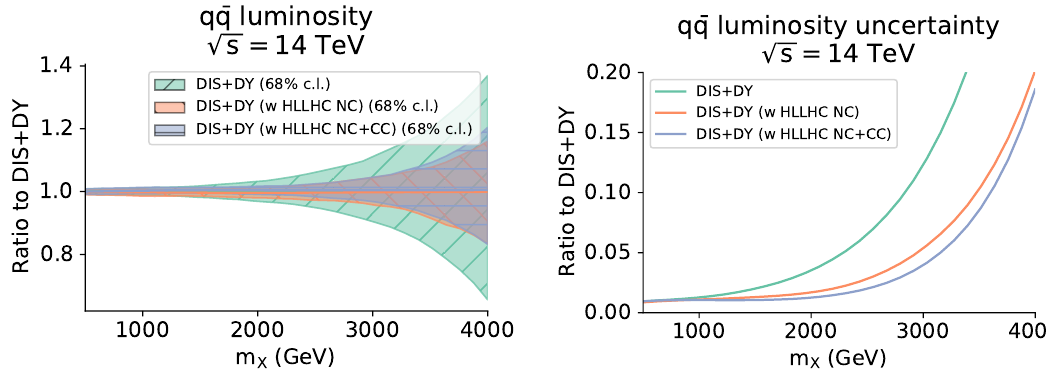
Figure 14 . Impact of the HL-LHC pseudo-data on the quark-antiquark luminosity L q ¯ q of the SM PDF baseline fit as a function of m X . Left: the luminosities L q ¯ q for the DIS+DY baseline and the corresponding fits including the HL-LHC pseudo-data, either only NC or also with CC cross sections, presented as a ratio to the central value of the former. Right: the relative PDF uncertainty in L q ¯ q (with the central value of the DIS+DY baseline as reference) for the same